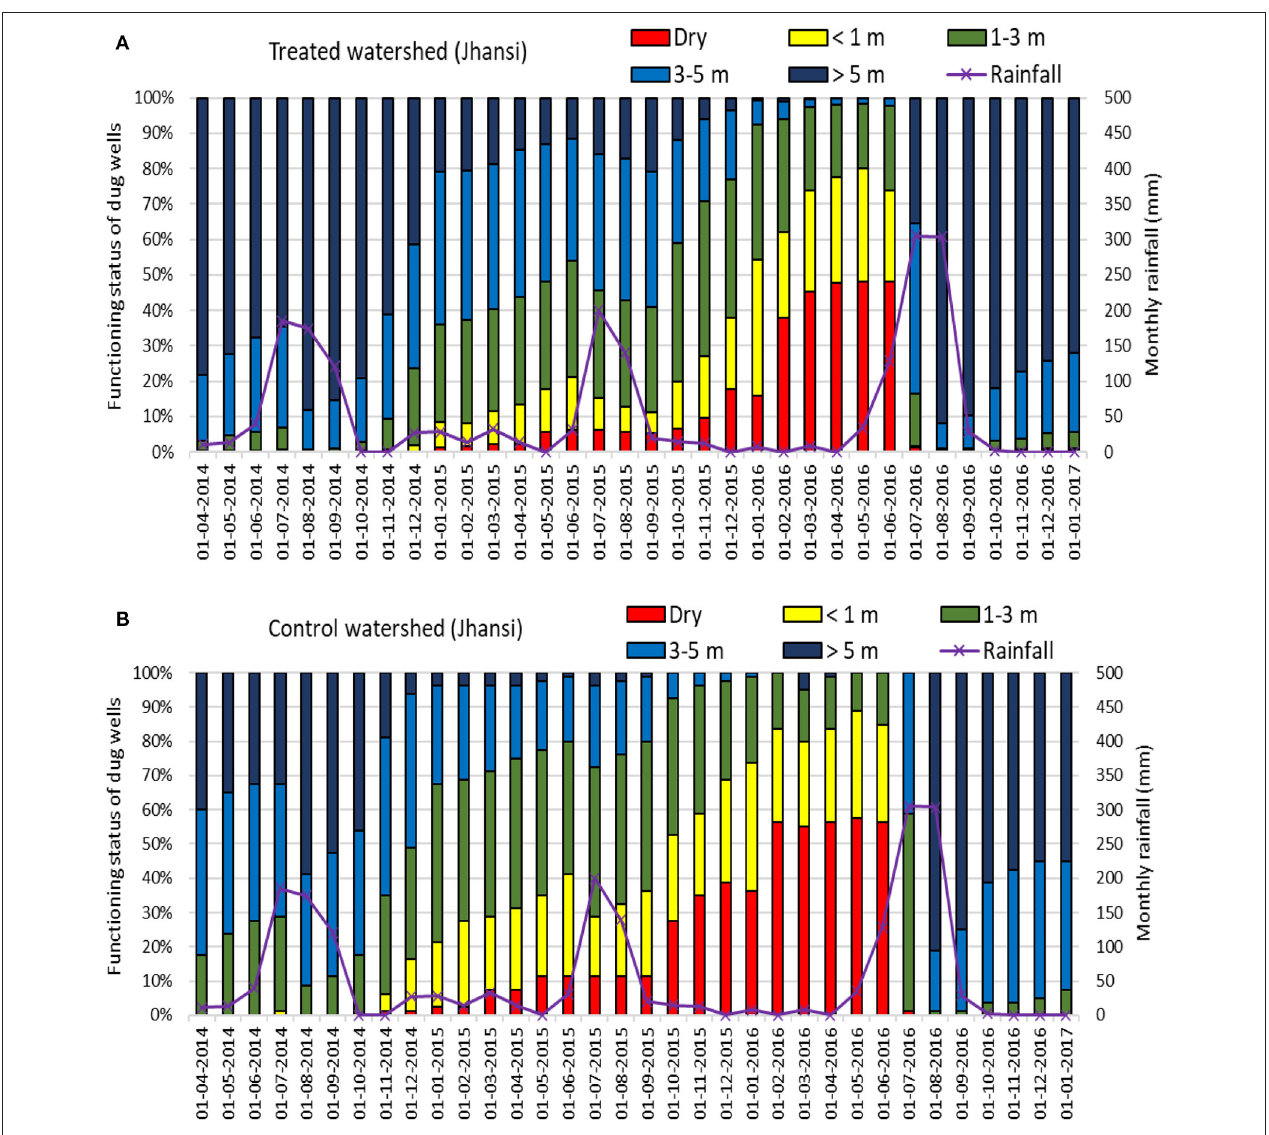
FIGURE 7 | Impact of RWH intervention on functioning status of dug wells in (A) treated and (B) control watersheds at Jhansi.